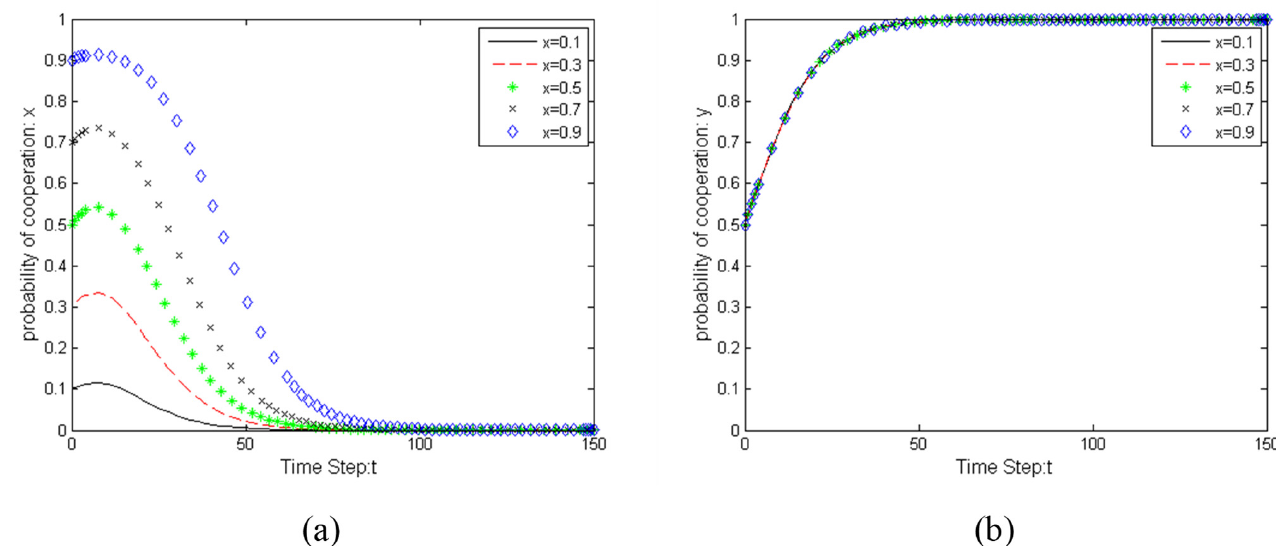
Figure 3. Evolution simulation, Scenario 3: ( a ) RDP; ( b ) hydropower developer.